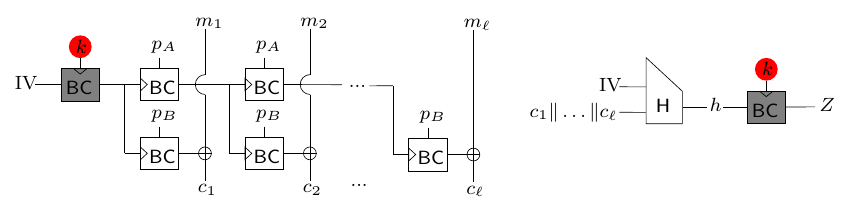
Figure 2: The AE mode EDT . E denotes a classical block cipher : EDT is a block cipher-based AEAD mode. The two dark blocks indicate two “leak-free” executions of E , while the others are leaky. p A and p B could be any two distinct constants, while in section 3.1 we consider the simplest case p A = 0 and p B =